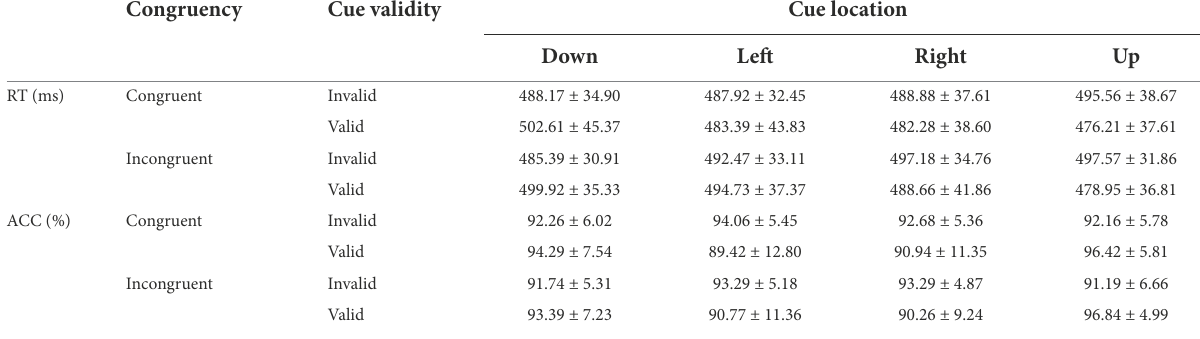
TABLE 3 The average response times and accuracy rates under the combinations of cue validity, cue-target semantic congruency and cue location in Experiment 2 (M ± SD).